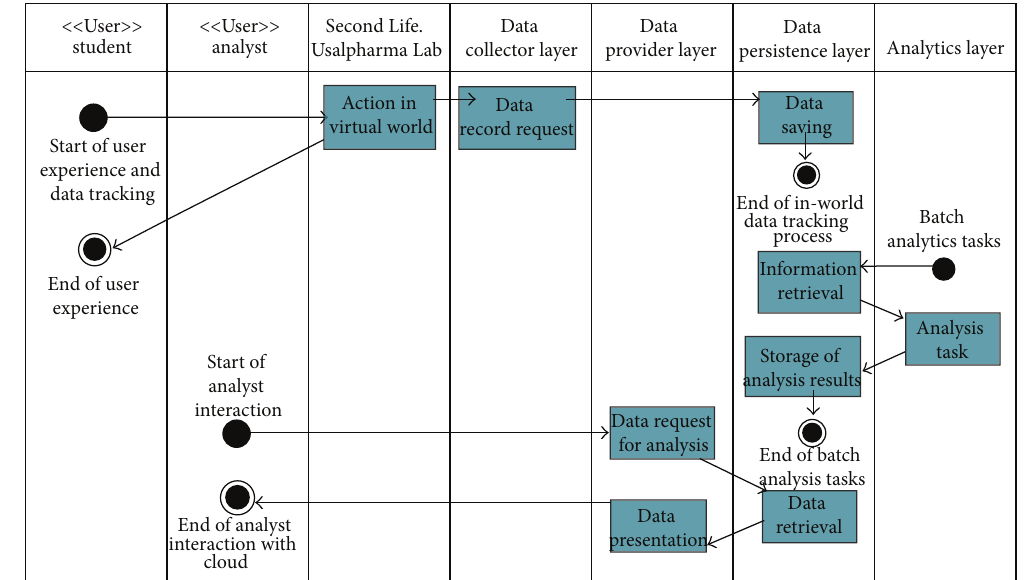
Figure 2: Activity diagram for Usalpharma